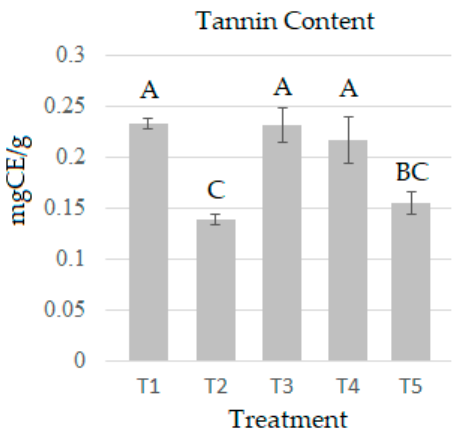
Figure 3. Tannin content in P. djamor over the five treatments. The bars indicate the mean of each experiment in triplicate with SE. Different letters indicate significant difference (T-Student p ≤ 0.05).